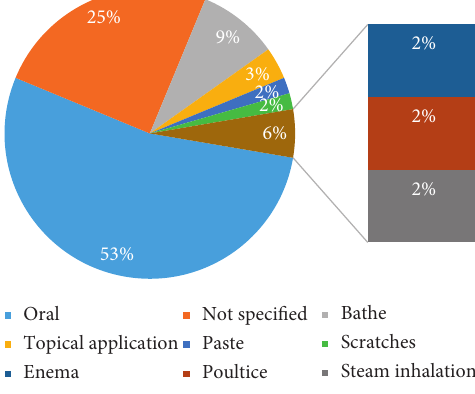
Figure 4: Frequencies of routes of